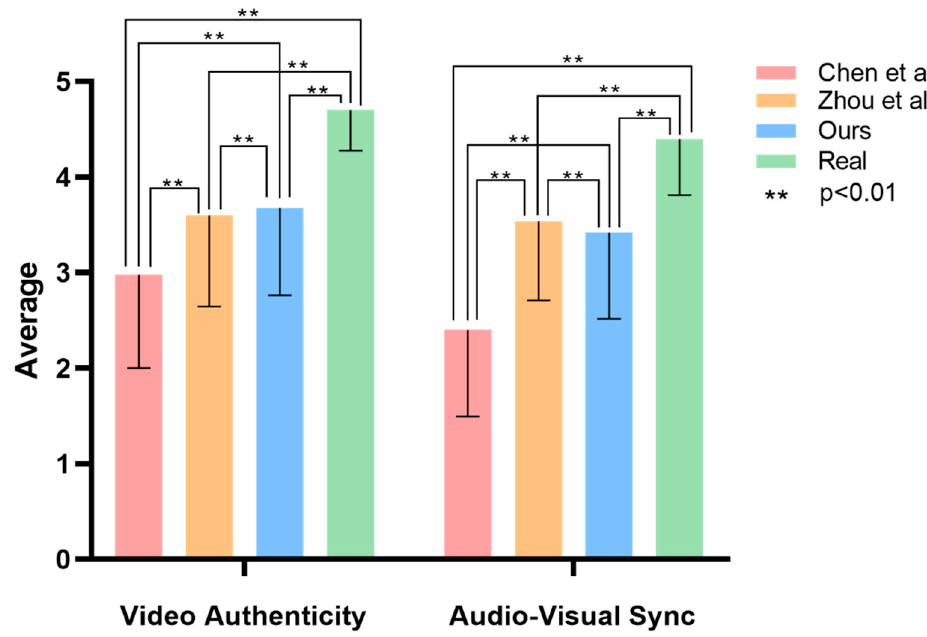
Figure 6. User study results of audio-visual sync and video authenticity (refs. [13,15]).